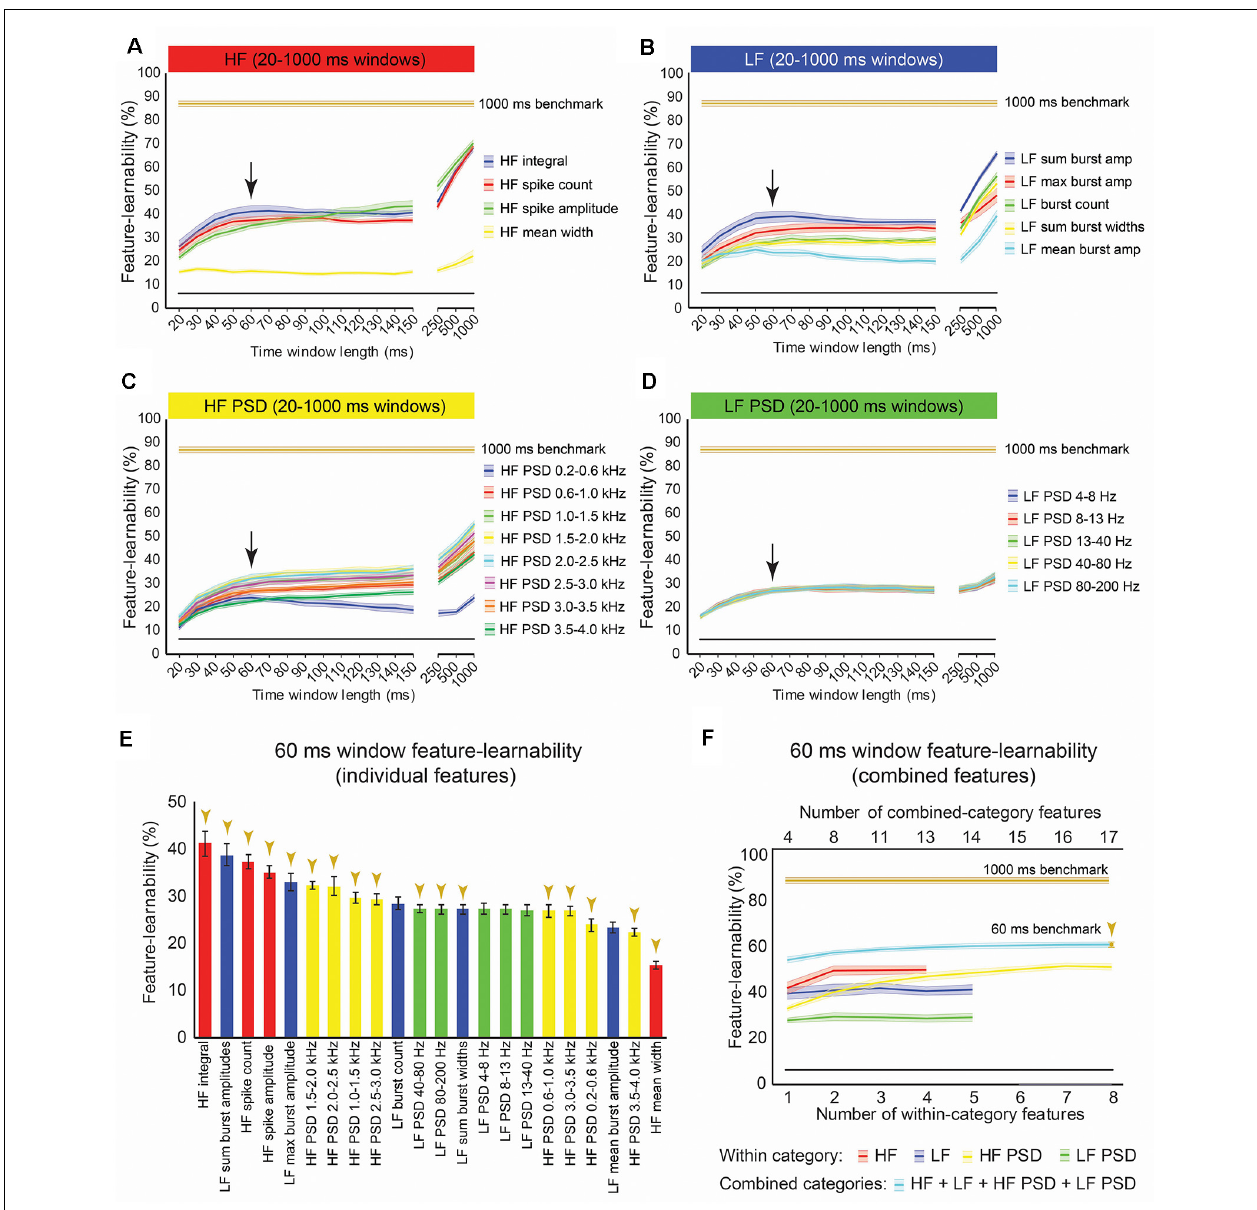
FIGURE 6 | Benchmark signal features for an optimal short-time window. (A–D) Feature-learnability of features extracted from time windows of varying lengths from 20 ms to 1,000 ms is shown in their HF (A) , LF (B) , HF PSD (C) , and LF PSD (D) signal feature categories. Colored lines and shading indicate the feature-learnability (mean ± SEM) for each signal feature (colors arbitrarily chosen). Gold lines indicate the 1,000 ms window benchmark feature-learnability ± SEM (see Figure 4D ) for comparison; black straight lines indicate classification chance level (6.25%). Arrows indicate the 60 ms window as the optimized duration across all features where the return of feature-learnability diminishes for increasing time windows. (E) Feature-learnability ranking of individual signal features is shown for the optimized short-time window (i.e., 60 ms). Gold arrows indicate the 13 signal features that comprise the benchmark configuration. (F) Benchmark signal features were determined for the optimized short-time window using the identical algorithm applied to determine the 1,000 ms window benchmark feature set shown in Figure 3A ; blue curve shows feature-learnability from combining across categories; gold arrow indicates benchmark configuration of 17 features (indicated in E). For comparison, the 1,000 ms window benchmark feature-learnability is shown (gold curve); the black straight lines indicate classification chance level (6.25%). See Figure 2 for feature descriptions and